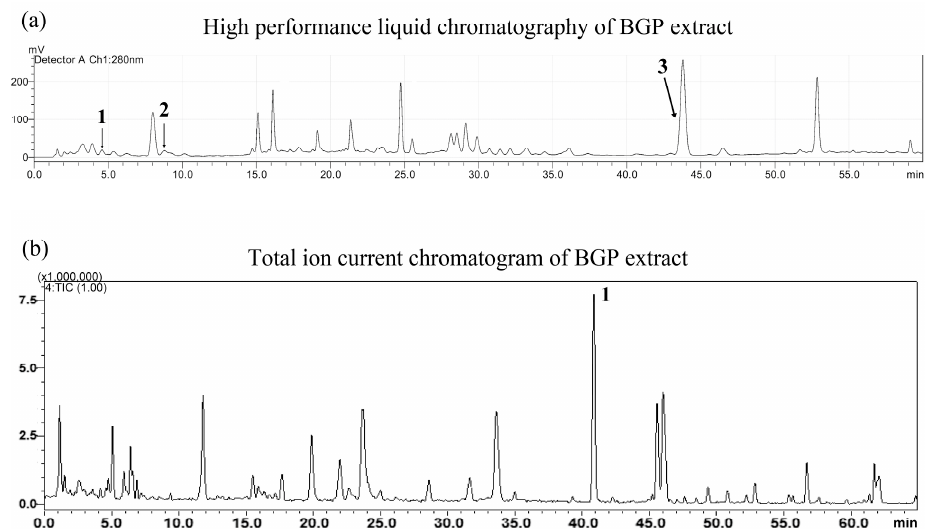
Figure 1. ( a ) HPLC chromatogram of Brazilian green propolis (BGP) extract. ( 1 : p -coumaric acid, Rt: 4.86 min; 2 : quercetin, Rt: 8.65 min; 3 : artepillin C, Rt: 44.0 min) ( b ) LC-IT-TOF-MS total ion current chromatogram (TIC) of BGP extract in the negative ion mode. 1 : artepillin C, Rt: 42.0 min (PubChem CID 5472440).